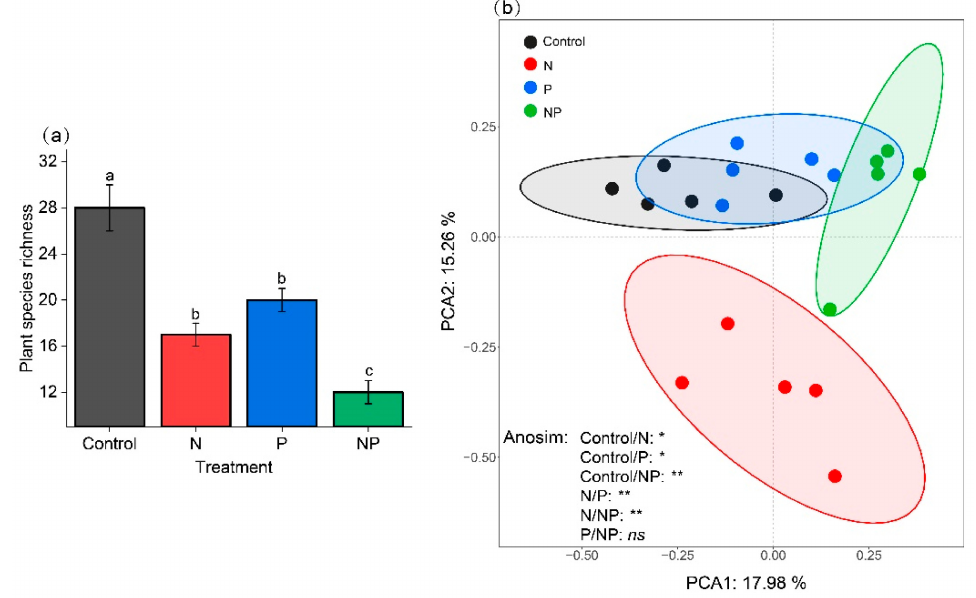
Figure 3. Effects of nitrogen and phosphorus addition on plant species richness (M ± SE, n = 5) and community composition, including ( a ) plant species richness; ( b ) plant community composition based on principal component analysis (PCA); and analysis of similarities (Anosim). Different letters indicate that the same index has significant differences between different treatments ( p < 0.05). *, **, and ns indicated p < 0.05, p < 0.01, and p > 0.05, respectively. Abbreviations: Control, the control without any nutrient addition; N, N-alone addition; P, P-alone addition; NP, N and P together